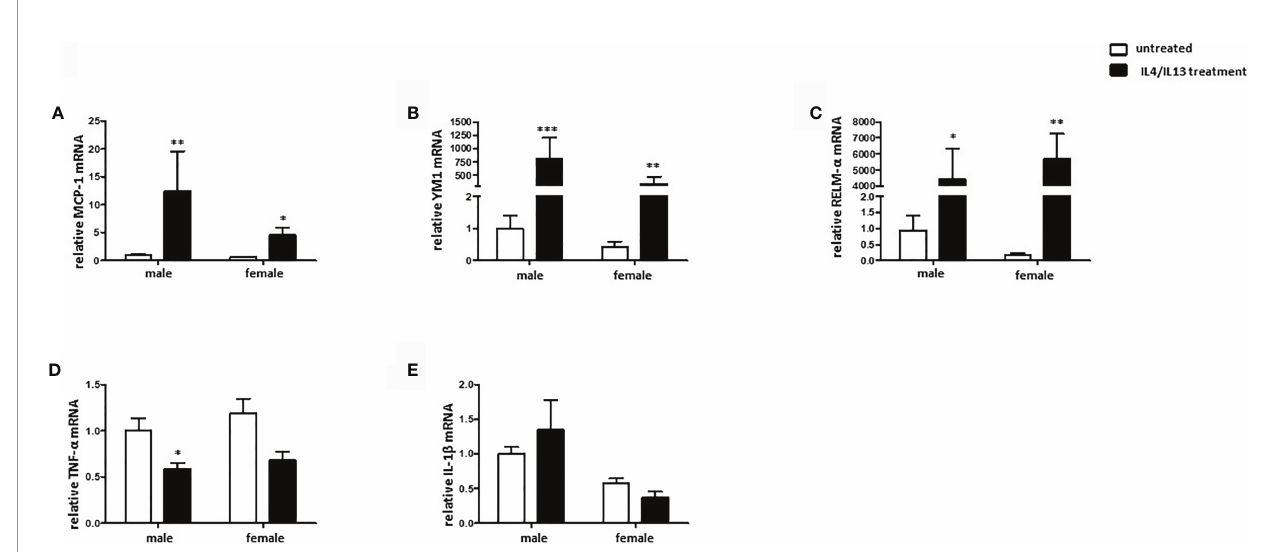
FIGURE 4 | MaleBMMs show a more prominent M2phenotype compared with females. Real-time PCR analyses of (A) MCP-1, (B) YM1, (C) RELM- a , (D) TNF- a , and (E) IL-1 b performed with bone macrophage lysates from maleand female mice treated with 10 ng/ml IL-4 and 10 ng/mlIL-13 for 24h.Data are shown as means ± SEM (n= 9; independent experiments with technical duplicates).Data are normalized to the maleuntreatedgroup.*p< 0.05, **p < 0.01, ***p < 0.001, untreated vs.